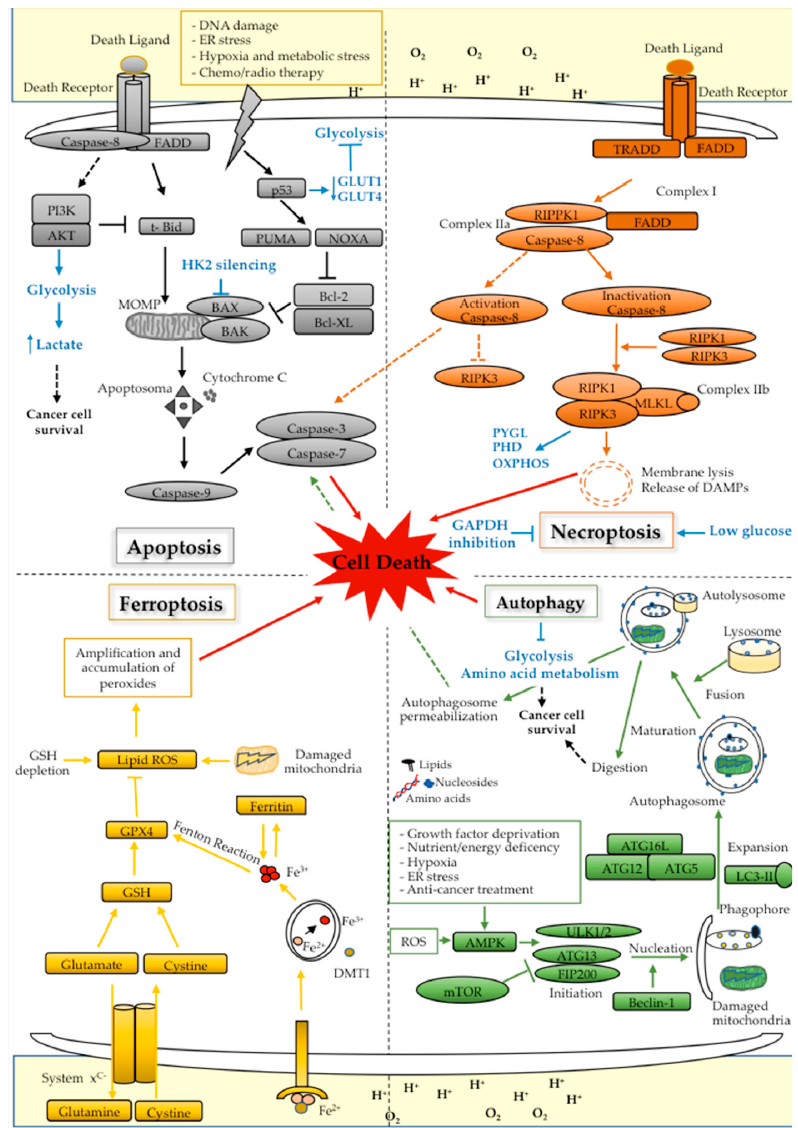
Figure 5. Biochemical pathways involved in different types of cell death. The scheme displays different pathways of cell death. A schematic representation shows the main molecules involved in the following pathways: Apoptosis (grey), Necroptosis (orange), Ferroptosis (yellow), and Au- tophagy (green). The text presented in blue indicates key molecules of some metabolic pathways that influence the processes of cell death or vice versa. Legend: ER, endoplasmic reticulum; FADD, FAS Associated protein with Death Domain; BCL-XL, B-cell lymphoma-extra large; BAX, BCL2 Associated X; BAD, BCL2 Associated Agonist Of Cell Death; t-Bid, truncated BH3 Interacting Domain Death Agonist; PI3K, Phosphoinositide 3-kinase; AKT, serine/threonine kinase; MLKL, Mixed lineage kinase domain-like protein; DAMPs, Damage-associated molecular patterns; DMT1, Divalent metal transporter-1; AMPK, AMP-activated protein kinase; mTOR, mammalian target of rapamycin; FLIP, Cellular FLICE-like inhibitory protein; LC3, Microtubule-associated protein 1A/1B-light chain 3; ROS, reactive oxygen species; OXPHOS, oxidative phosphorylation; GSH, reduced glutathione; Bcl-2, B-cell lymphoma 2; GLUT, glucose transporters; HK2, hexokinase 2; GAPDH, glyceraldehyde-3-phosphate- dehydrogenase; MOMP, outer mitochondrial membrane; PUMA, p53 upregulated modulator of apoptosis; ULK1/2, autophagy initiating kinases 1/2; RIP, receptor-interacting protein; TRADD, TNFR-associated death domain; PYGL, glycogen phosphorylase, GPX4, glutathione-dependent peroxidase